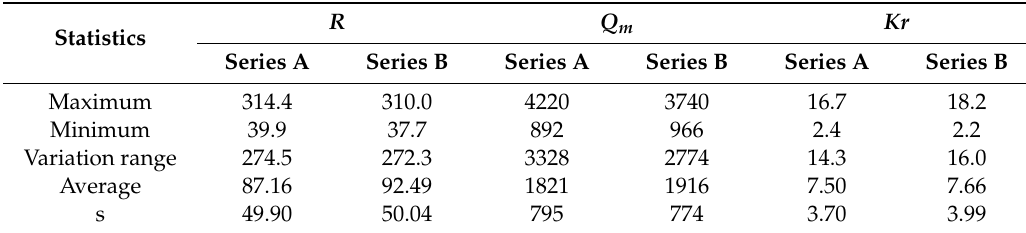
Table 8. The result of hydrologic variables in Dapoling basin.